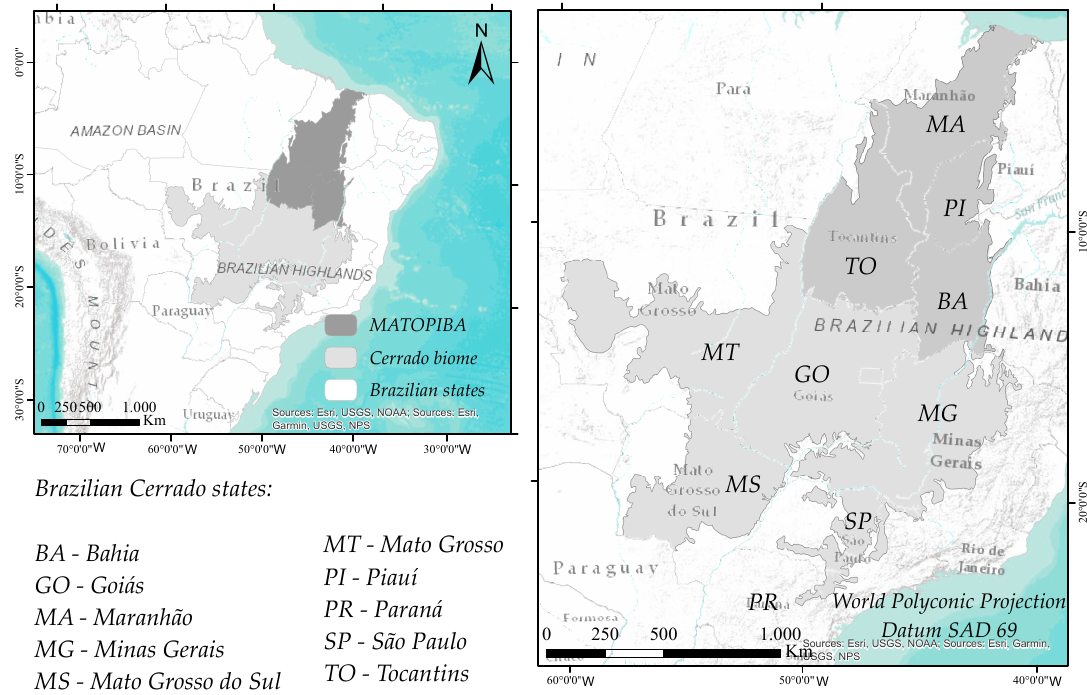
Figure 1. Location of the study area. The Brazilian Cerrado encompasses totally or partially the states of Bahia (BA), Goi á s (GO), Maranh ã o (MA), Minas Gerais (MG), Mato Grosso do Sul (MS), Mato Grosso (MT), Piau í (PI), Paran á (PR), S ã o Paulo (SP), and Tocantins